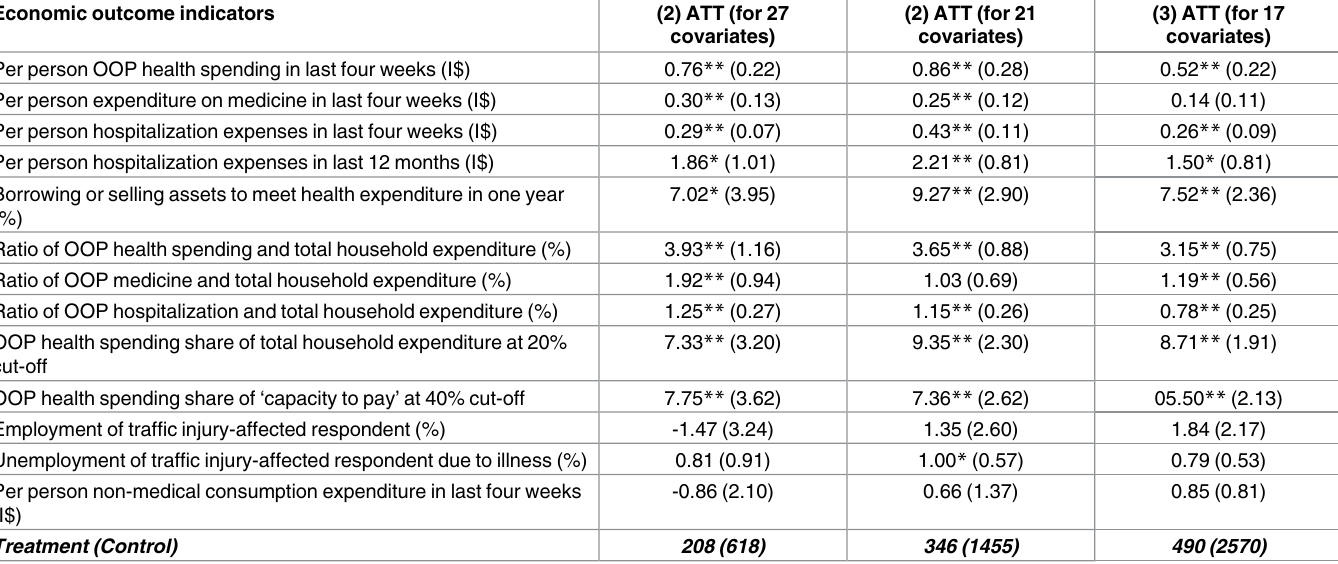
Table 4. Economic Impacts of Road Traffic Injuries on Households, South Asia, 2003: Average Treatment Effect on the Treated (ATT)-Robust- ness Checks. Economic outcome